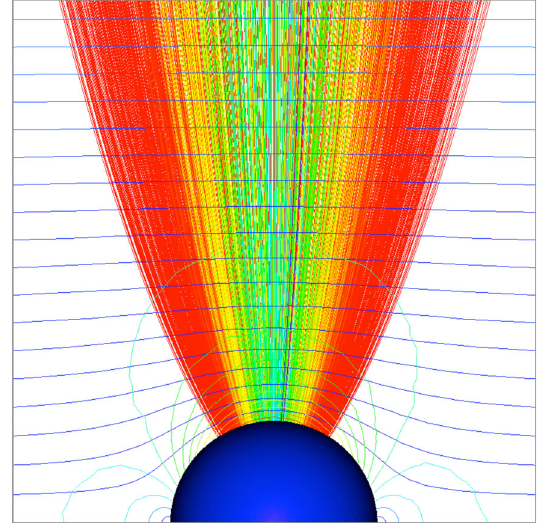
FIG. 3. Same as Fig. 2 inset but showing larger side view with overlaid equipotentials (thin dark blue lines) and field magnitudes (thin light blue lines). The “ notional ” emission angle introduced in Sec. III C and defined by Eq. (15) is comparable to the launch origin of the yellow